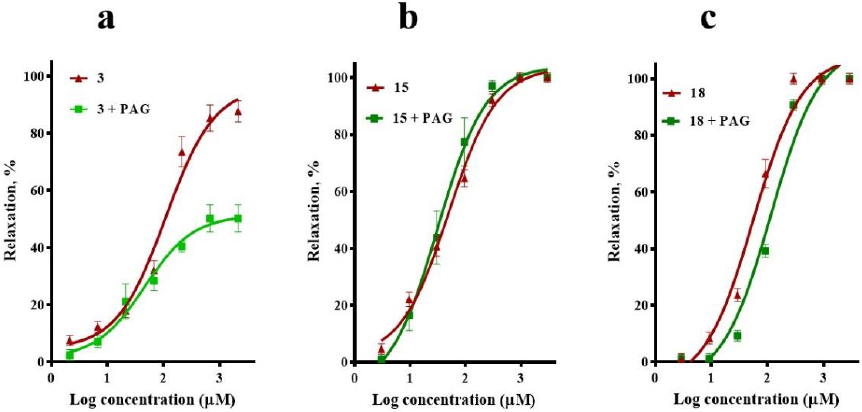
Figure 5. Vasodilatory effect of ( a ) corosolic acid ( 3 ), ( b ) meso -dihydroguaiaretic acid ( 15 ), and ( c ) 5,8,4′-trihydroxy-3,7-dimethoxyflavone ( 18 ) in the absence (control) and presence of propargylglycine (PAG, 1 mM). Analysis by one-way ANOVA was made between the curves of each compound in the absence and presence of PAG followed by a post hoc Tukey’s test ( 3 , p = 0.001; 15 , p = 0.803; 18 , p = 0.102).